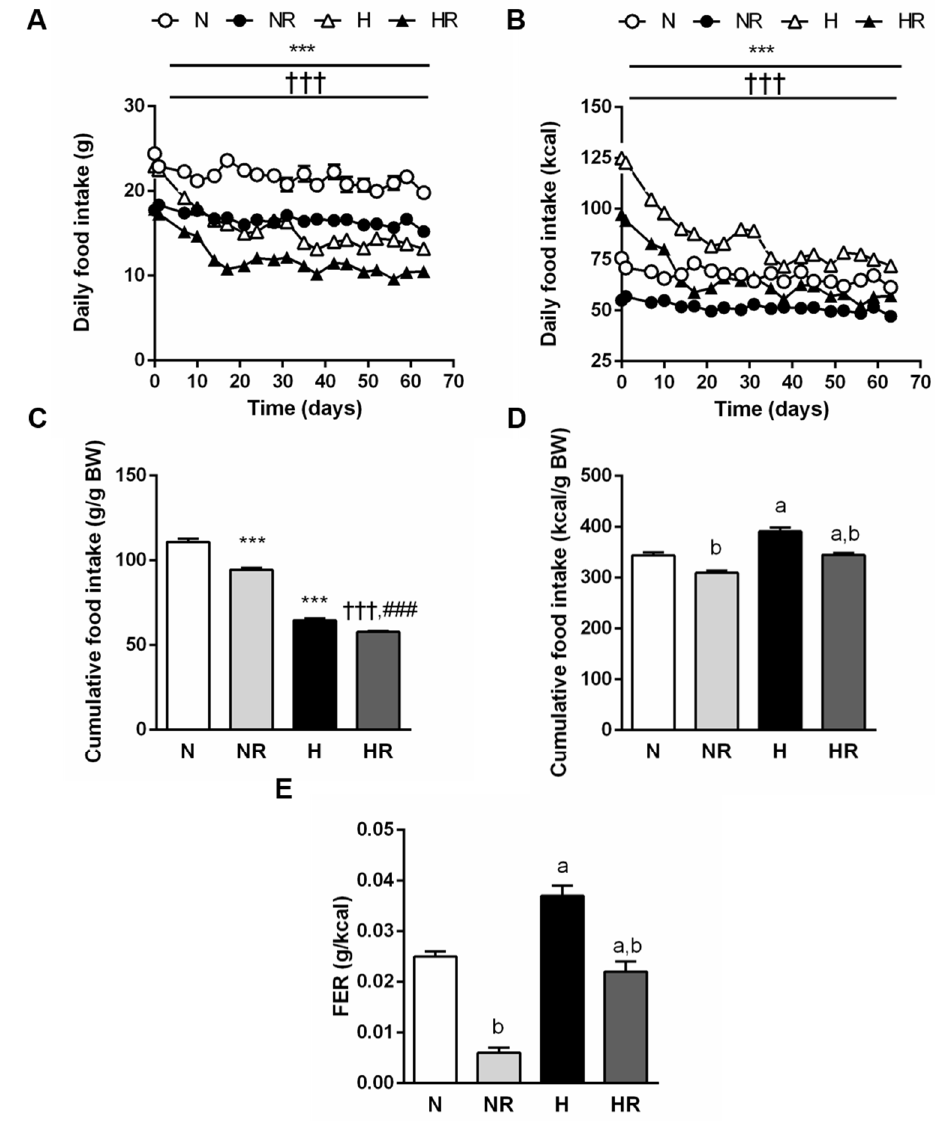
Figure 3. Curves of daily food intake in grams ( A ) and kilocalories ( B ) of the experimental animals ( n = 10 per group). Bar graphs represent cumulative food intake relative to body weight in grams ( C ) and in kilocalories ( D ) as well as food efficiency ratio (FER) ( E ) during dietary interventions. a p < 0.05 effect of diet; b p < 0.05 effect of caloric restriction. *** p < 0.001 vs. the same group fed a ND; ††† p < 0.001 vs. the same group fed ad libitum; ### p < 0.001 vs. N.